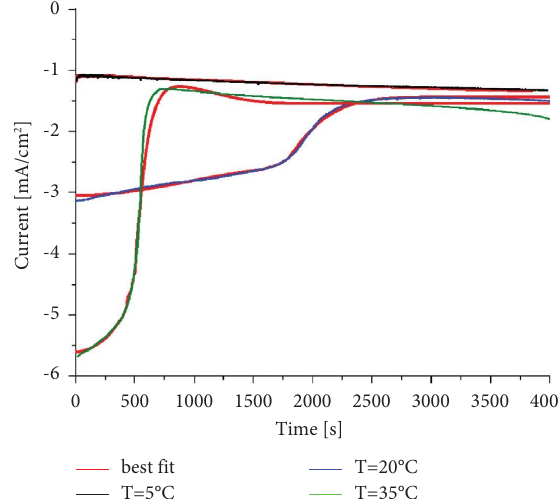
Figure 3: Current density toward time recorded during the electrodeposition of Pb 2+ on an FTO electrode. Black, blue, and green lines are the experimental results for T � 5, 20, and 35 ° C, respectively. Te red line corresponds to their best